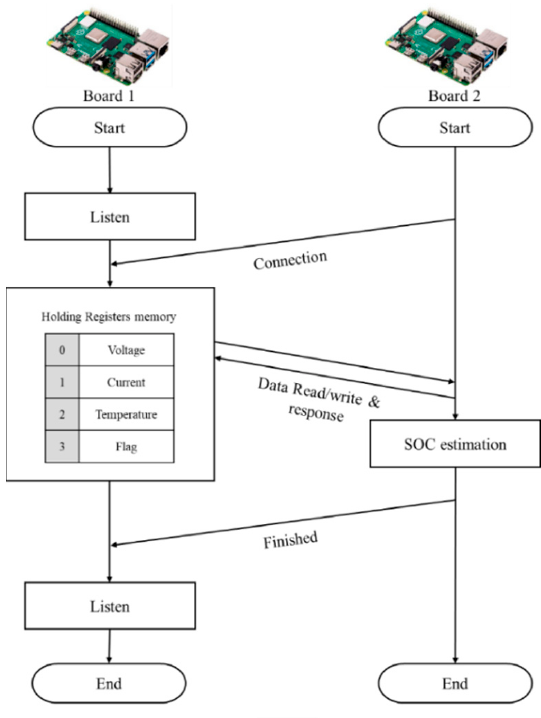
Figure 7. Experimental setup of Raspberry Pi.